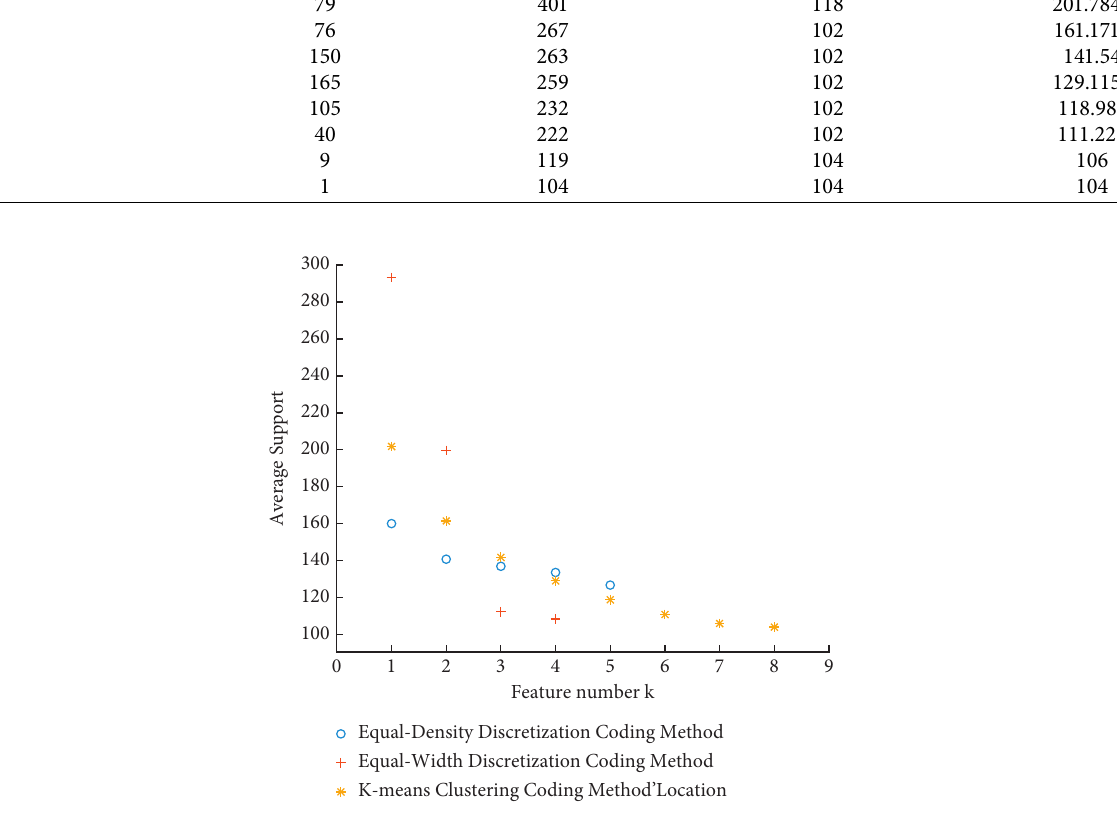
Table 7: Frequent feature pattern mining results based on the K -means clustering coding method. Frequent feature k -patterns